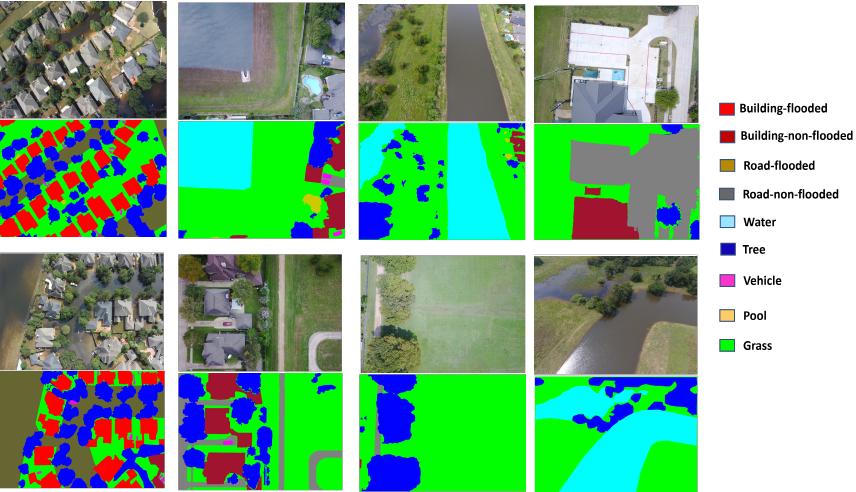
Figure 4. Sample images of the dataset. First and third row show the sample images, while second and fourth row represent the ground truth